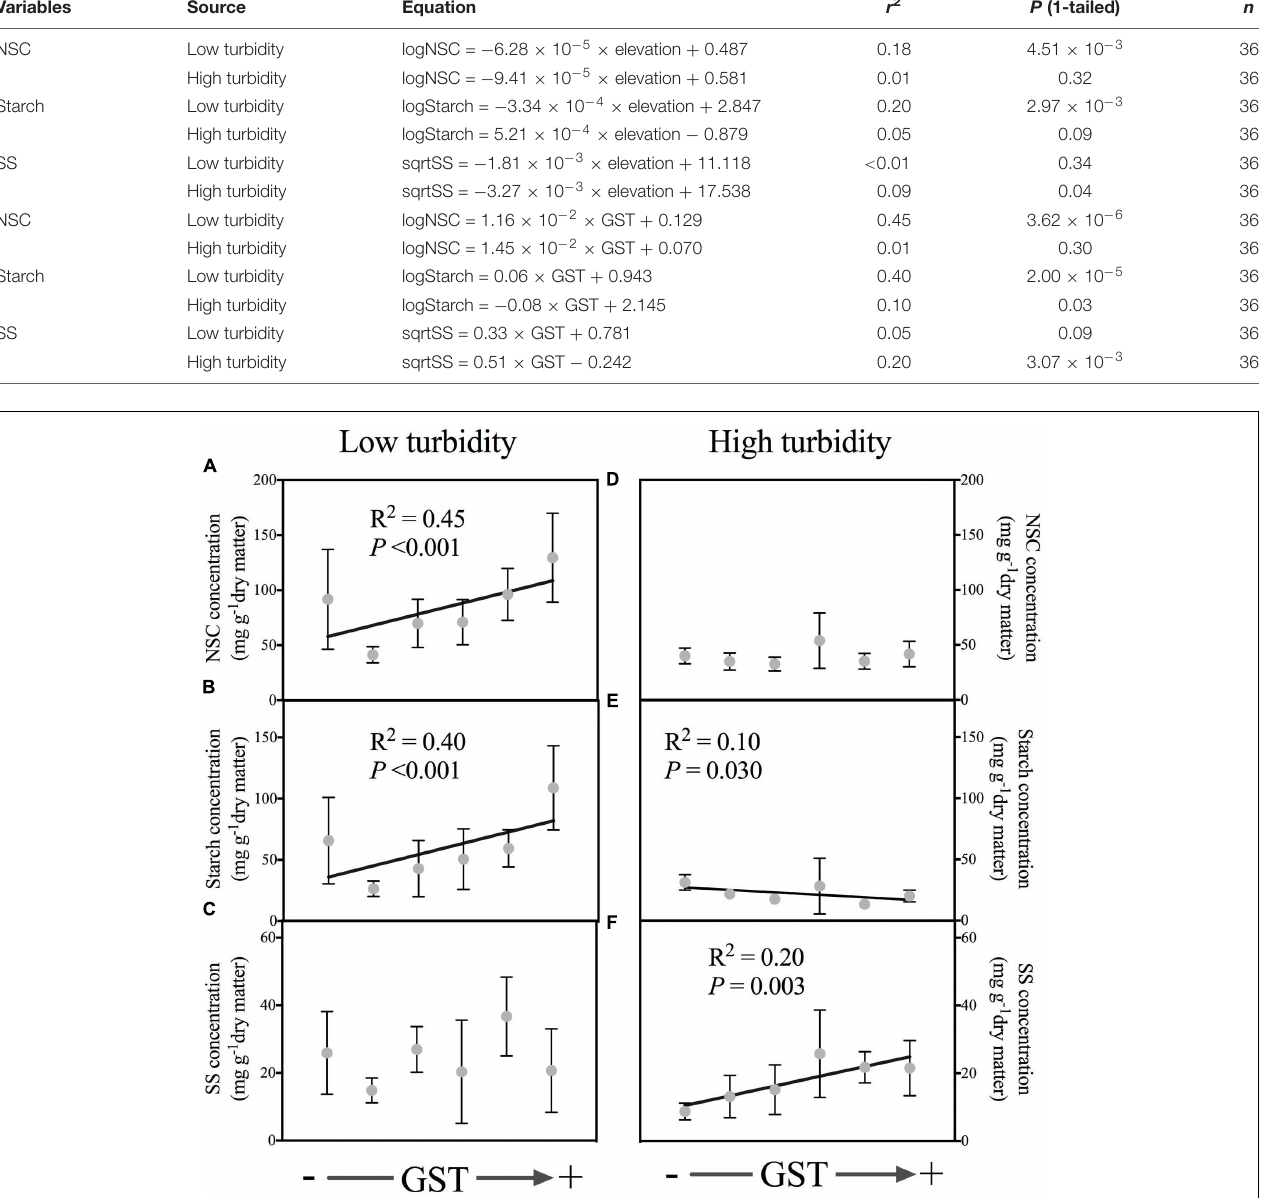
TABLE 1 | Equations and R 2 and P values for non-structural carbohydrate (NSC), starch and soluble sugar (SS) concentrations in relation to elevation (m) and growth season temperature (GST, ◦ C) for the Myriophyllum species. Model II linear equations were introduced to fit the data. Variables